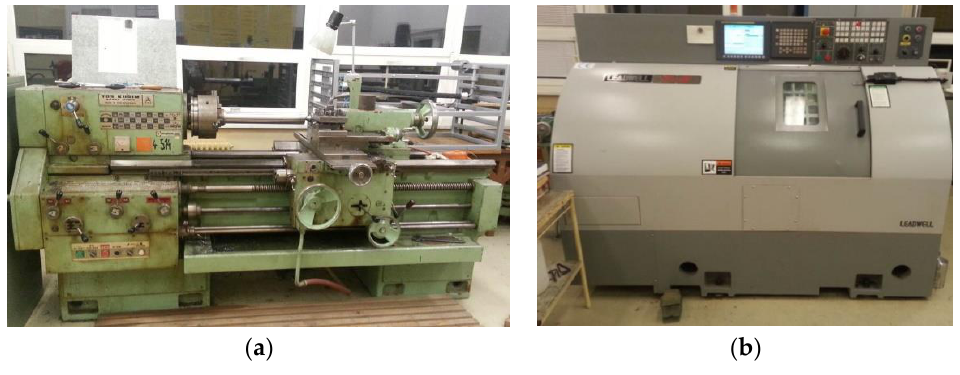
Figure 1. Machine tools: SU 50 A ( a ) a CNC Leadwell T-5 ( b ).